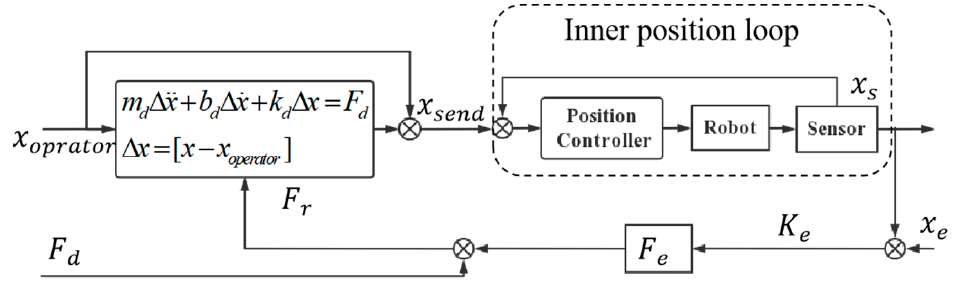
Figure 4. The strategy of integrated position/force controller.